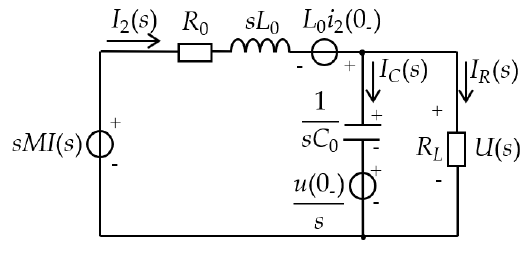
Figure 9. S domain equivalent circuit.